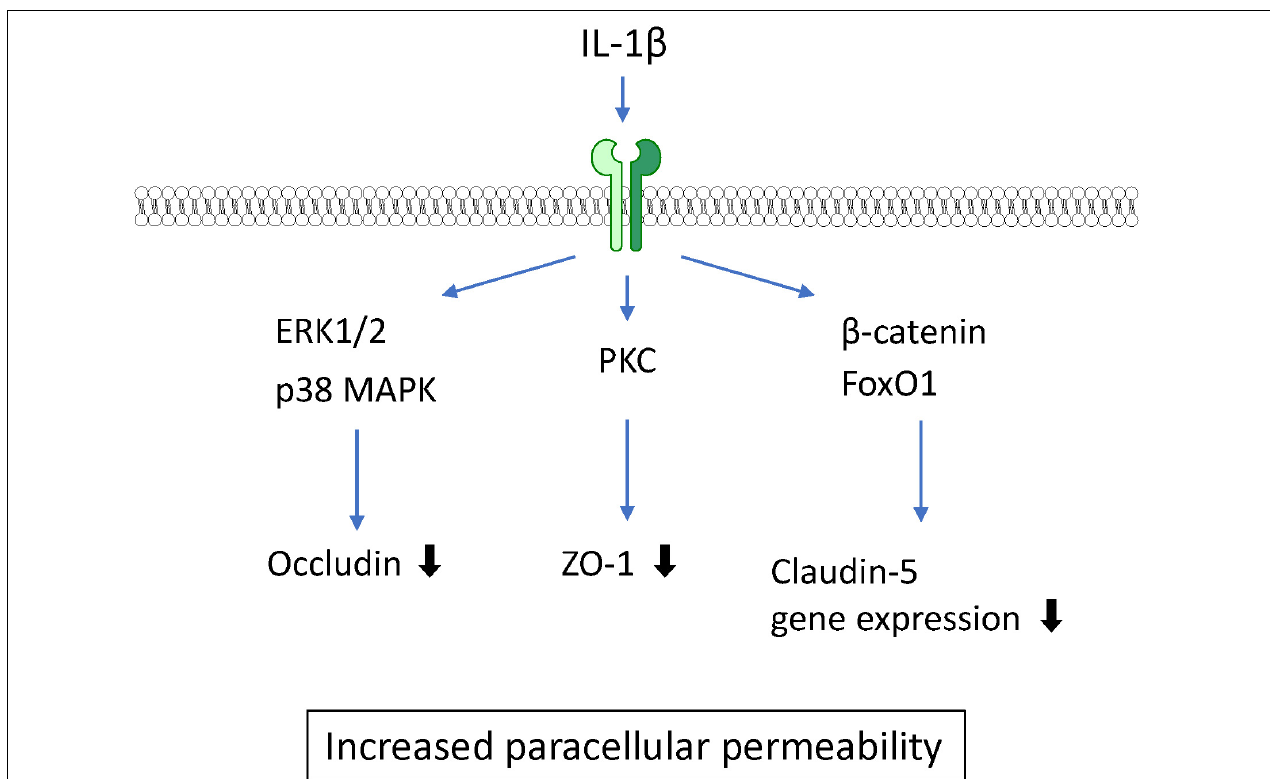
FIGURE 3 | Intracellular signaling pathways induced by IL-1 β in BMECs leading to BBB